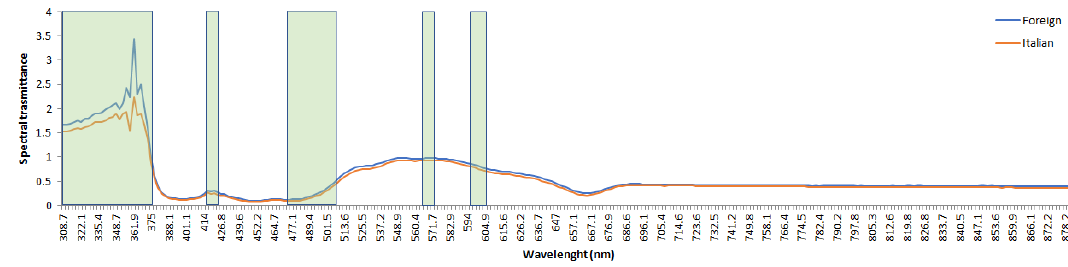
Figure 6. Mean VIS-NIR spectral data: Italian (red line), foreign (blue line). Higher importance spectral values in terms of artificial neural network (ANN) feature importance are evidenced with green rectangles.